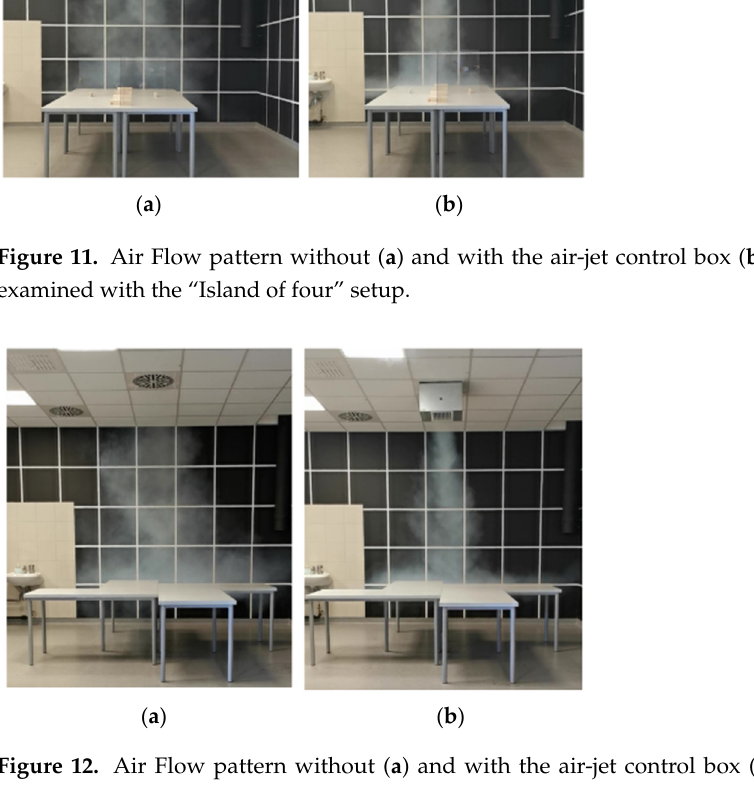
Figure 12. Air Flow pattern without ( a ) and with the air-jet control box ( b ) examined with the “Flower” setup.